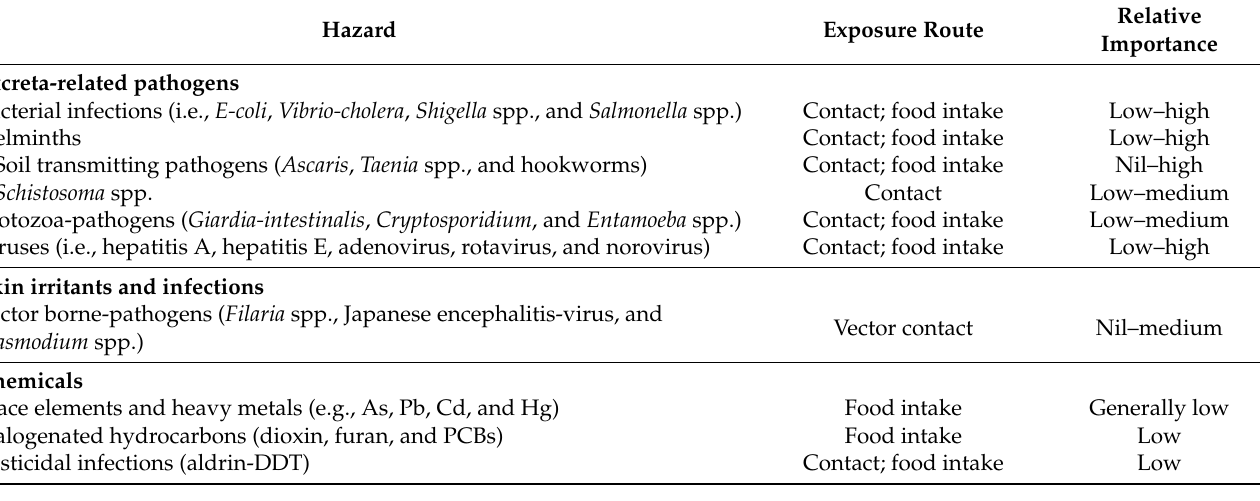
Table 5. Different types of risks supplementary with domestic sewage use as irrigation in the developing countries globally [75,102,103]. Hazard Exposure